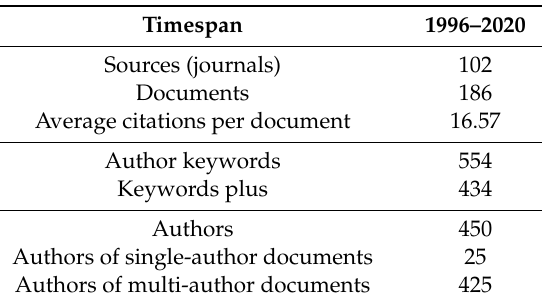
Table 2. General data summary.